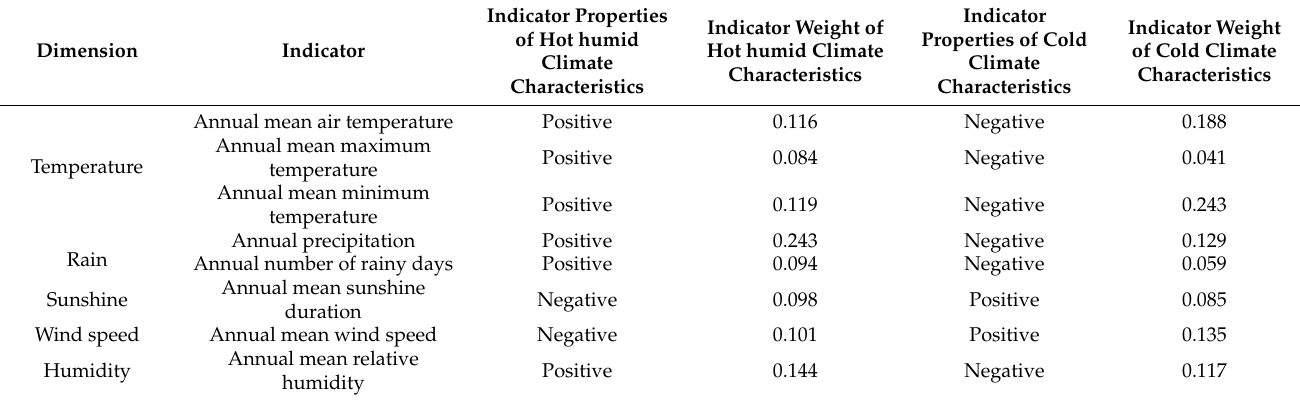
Table 1. Weighting of indicators for the evaluation of regional climate